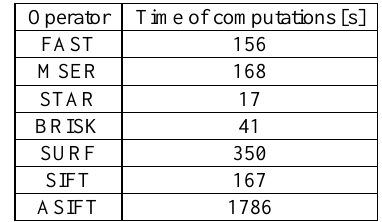
Table2 Time of computations of algorithms for searching and